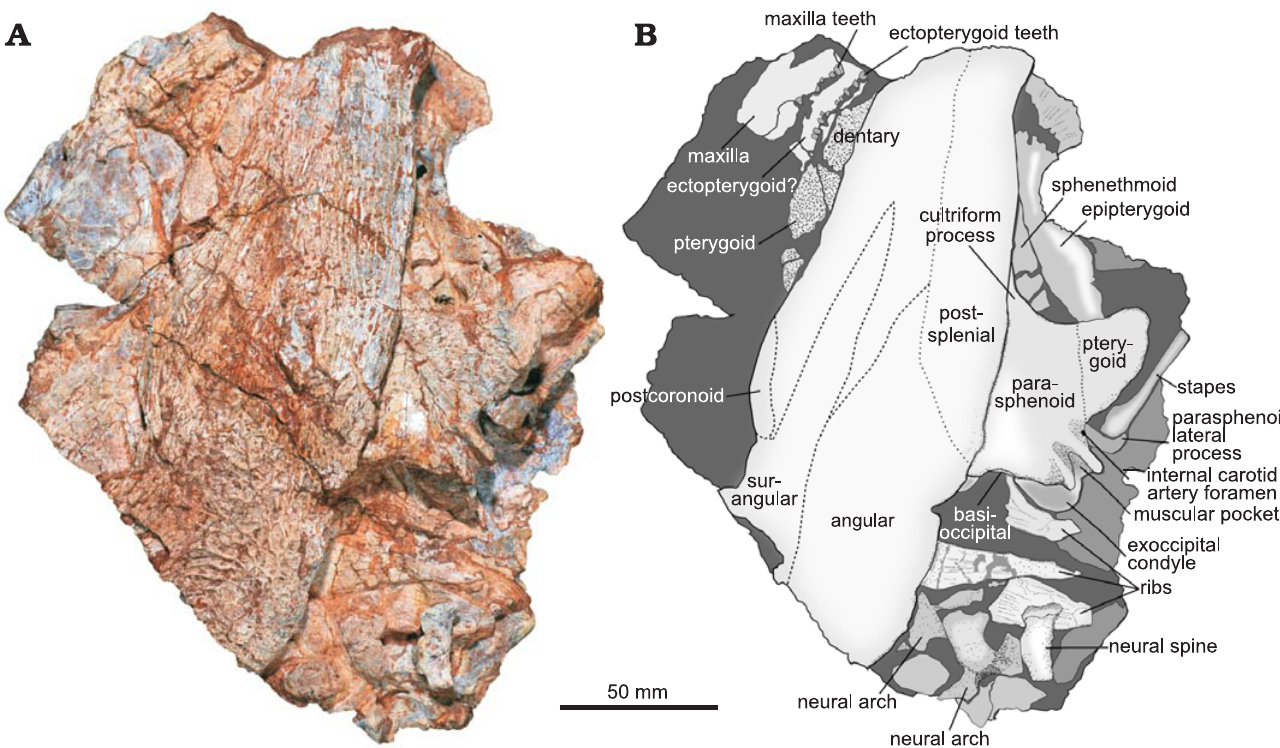
Fig. 3. Stereospondylomorph temnospondyl Parapytanga catarinensis gen. et sp. nov. (holotype, UFRGS-PV-0355-P) from the Santa Catarina State (Brazil), Middle–Upper Permian. Side of the sample containing the skull in palatal view (elements from palate and braincase); stapes; right hemimandible in labial view; fragments of vertebrae and ribs. Photo ( A ) and interpretative drawing ( B